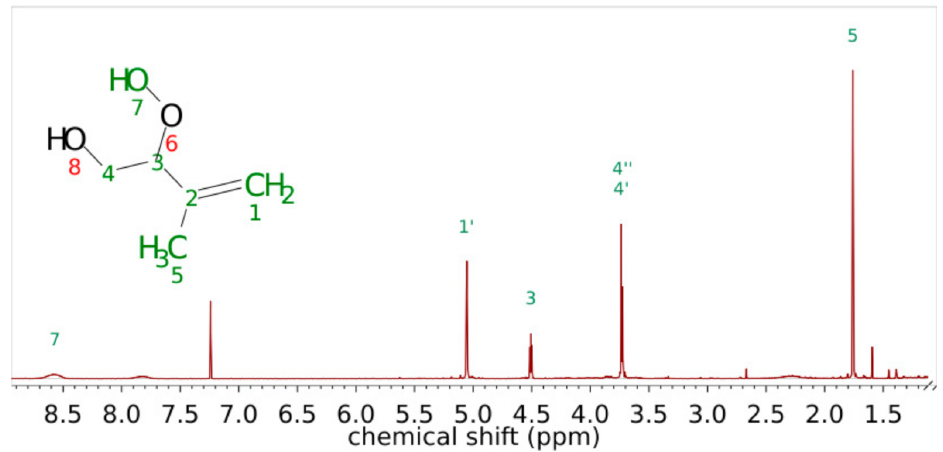
Figure 5. 1 H-NMR spectrum of 4,3-ISOPOOH in CDCl 3 at 600